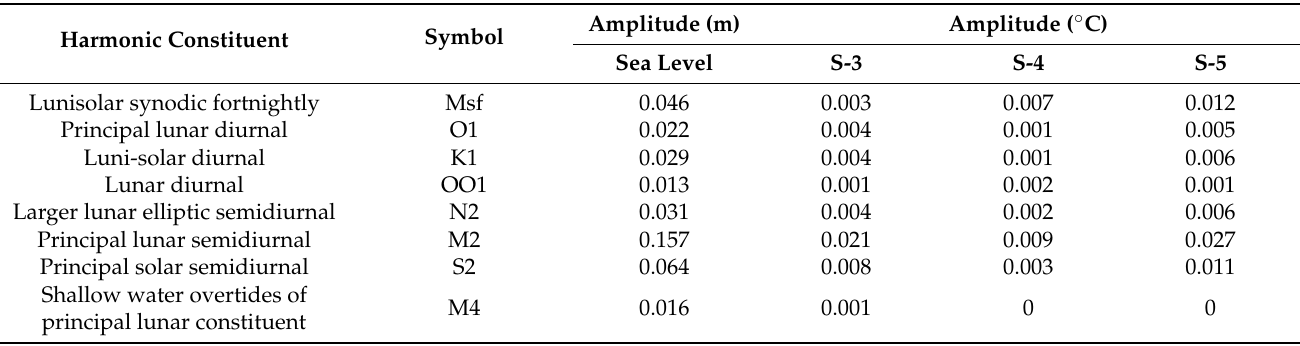
Figure 8. ( a ): Continuous measurements of sea level and temperature were obtained from S-3, S-4, and S-5 during February 2018. ( b ): Density spectra (energy versus frequency) of the temperature data obtained during February 2018. ( c ): Cross-correlation functions of sea level as input and temperature measured in S-3, S-4 and S-5 as output for February 2018. Table 4. Main tidal constituents of the Mediterranean Sea and the temperature measured in S-3, S-4, and S-5, obtained with S_TIDE